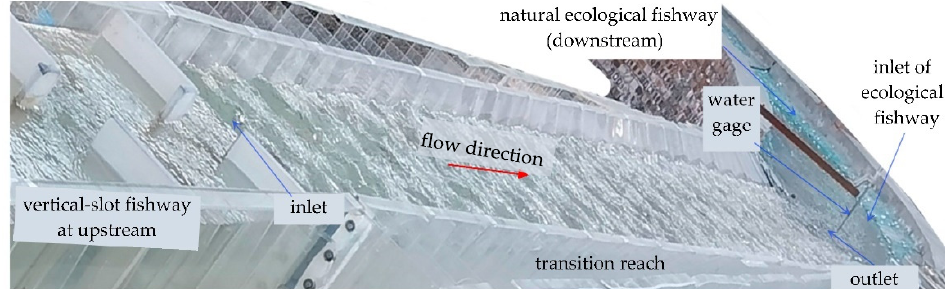
Figure 24. Water surface of the transition reach with the DWO in the hydraulic model. The waves on the water surface decreased, obviously, and the turbulent intensity was reduced evenly by one-third. After the local head drop around each weir plate greatly decreased, the gradient of the water surface became mild. Another important point: the water surface was continuous and complete, and the entire artificial building could be hidden in the water, which caused the fishway to appear similar to a natural river. It can be seen that the flow regime in the channel adopting the DWO became more gentle, without a strong vortex, which supplies the suitable mild dynamics of a migration environment.